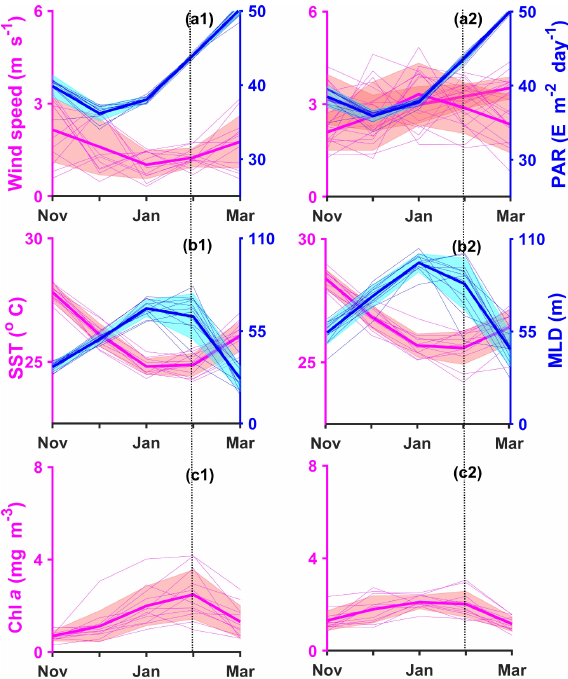
Figure 7. Temporal variability of alongshore wind speed and PAR (a) , SST and MLD (b) and surface Chl a (c) averaged for zone 5 (left, denoted by suffix 1) and zone 6 (right, denoted by suffix 2) during the winter period for the years 2002–2013. Pink colour is used to represent Chl a , SST and wind speed and blue represents MLD and PAR. Thick lines represent means and the shaded areas the standard deviation for each parameter. The time series for the individual years are shown using thin lines. Vertical dotted lines represent the timing (month) of peak algae blooms in each